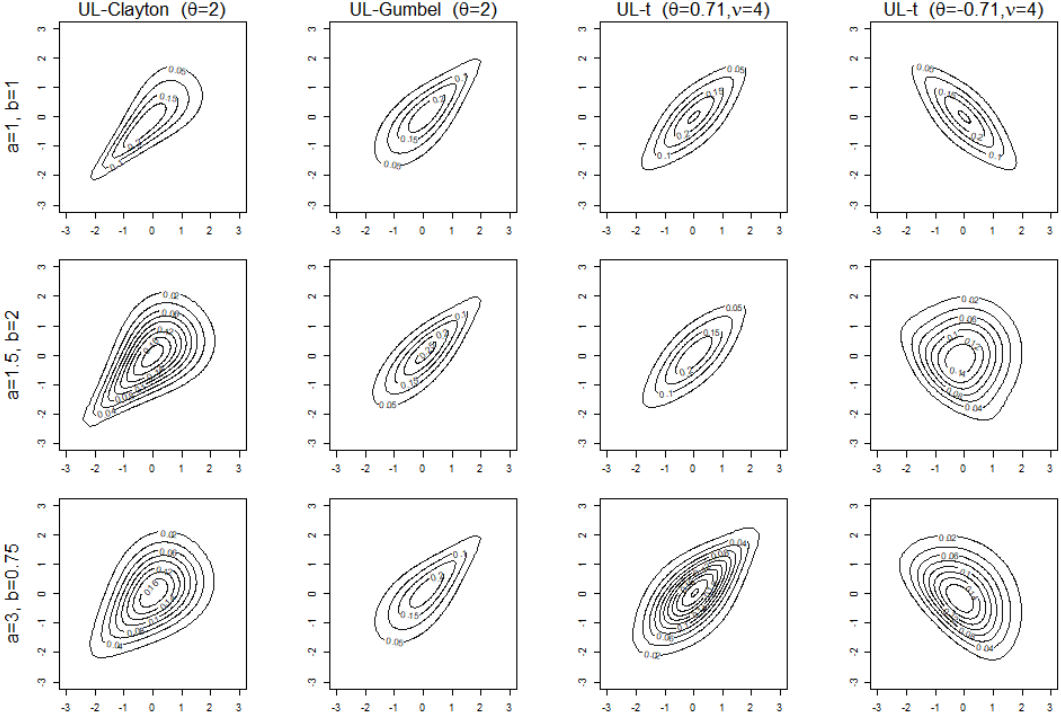
Figure 4. Density contour plots constructed from using the UL-distorted copulas with standard normal margins and parameter values ( a , b ) = ( 1,1 ) , ( 1.5,2 ) , and ( 3,0.75 )